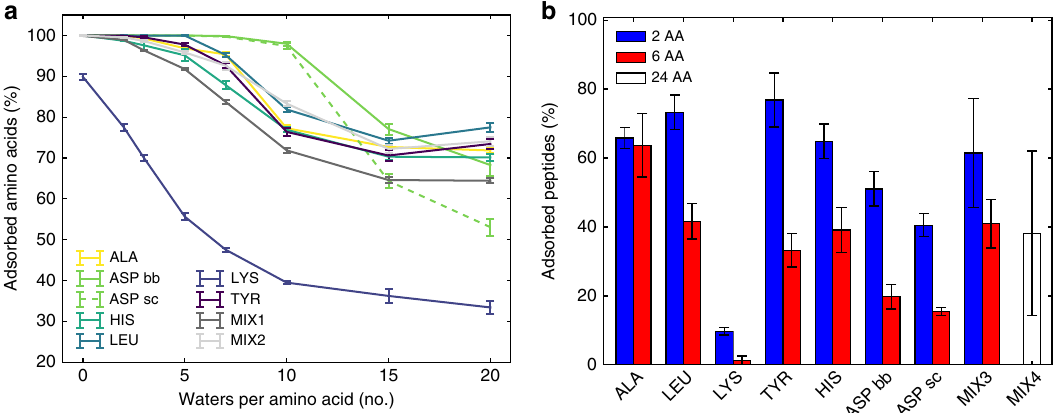
Fig. 2 Amino acids and peptides adsorbed onto LDH. a Percentage of adsorbed amino acids as a function of their hydration (number of water molecules per amino acid). b Percentage of adsorbed di-peptides, hexa-peptides, and 24-mers in a fully hydrated system. Error bars represent standard deviation. With the exception of lysine, both single amino acids and peptides adsorb onto the LDH surface (distance < 2.5 Å). Aspartate can adsorb both via its backbone (labeled ASP bb) and side-chain (ASP sc). Though less adsorbed than di-peptides, hexa-peptides, and 24-mers still feature signi fi cant adsorption rates, indicating that chain length has only a minor effect on peptide